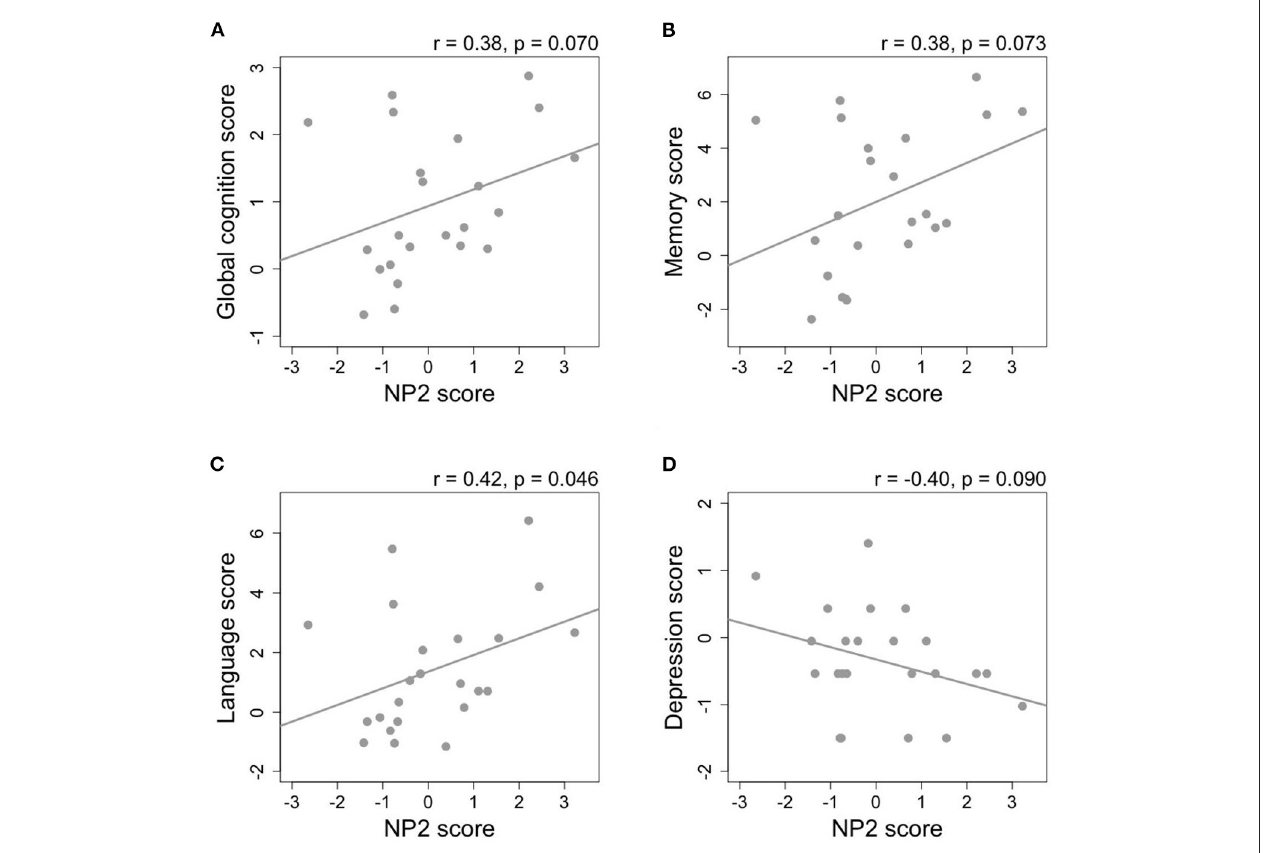
FIGURE 3 | The relationship between nutrient pattern 2 (NP2) score and composite scores of (A) global cognition, (B) memory, (C) language, and (D) depression among non-demented subjects (Global Deterioration Scale = 1–3, n = 23). Pearson’s correlation coefficients are adjusted for sex, education, diabetes, hypertension, and APOE ε 4